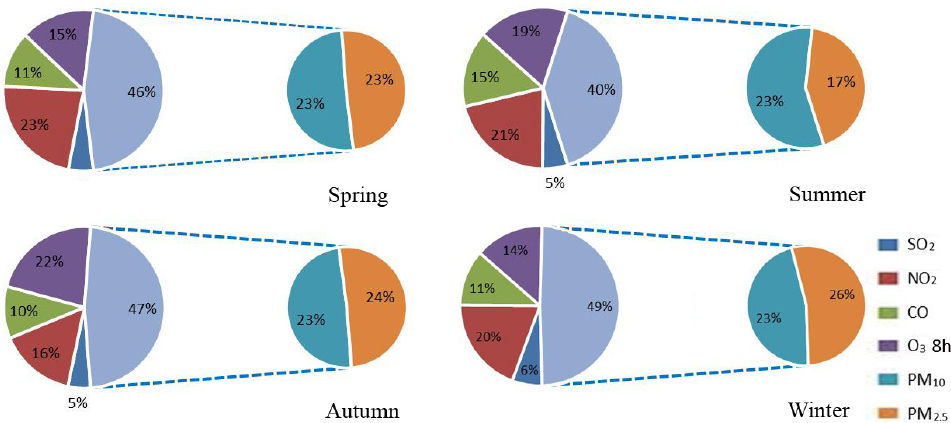
Figure 5. Air pollutant compositions by season in Shenzhen from March 2013 to February 2014.